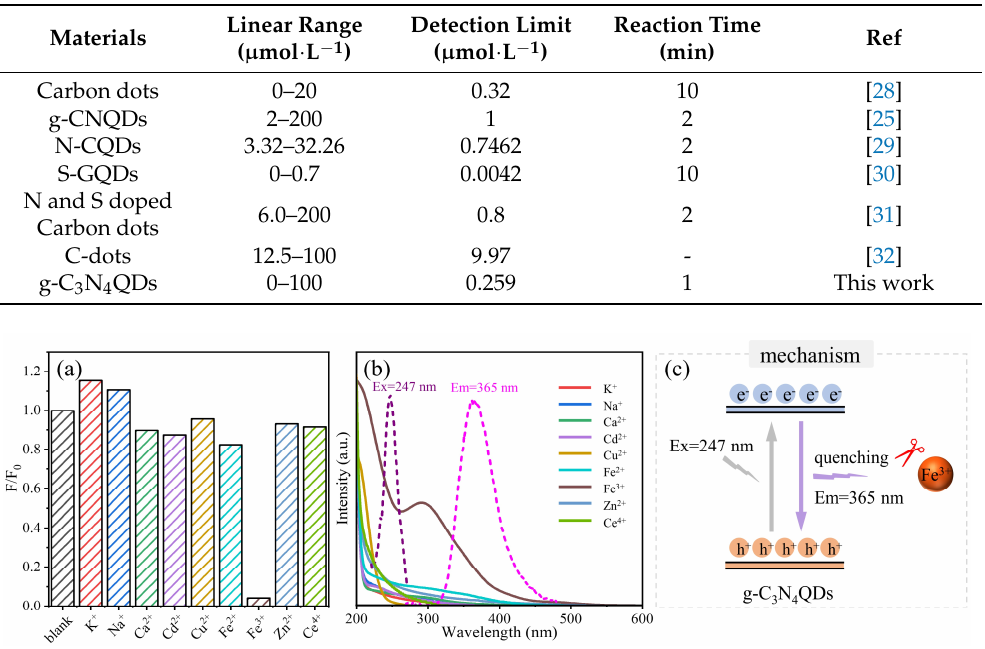
Figure 6. ( a ) PL response of the g-C 3 N 4 QDs (0.050 mg/mL) in the solution of common metal ions (100 μM). ( b ) UV-vis absorption spectrum of common metal ions and the PL excitation and emission spectra of the g-C 3 N 4 QDs. ( c ) Proposed fluorescence quenching mechanism of the g-C 3 N 4 QDs in the presence of Fe 3+ .